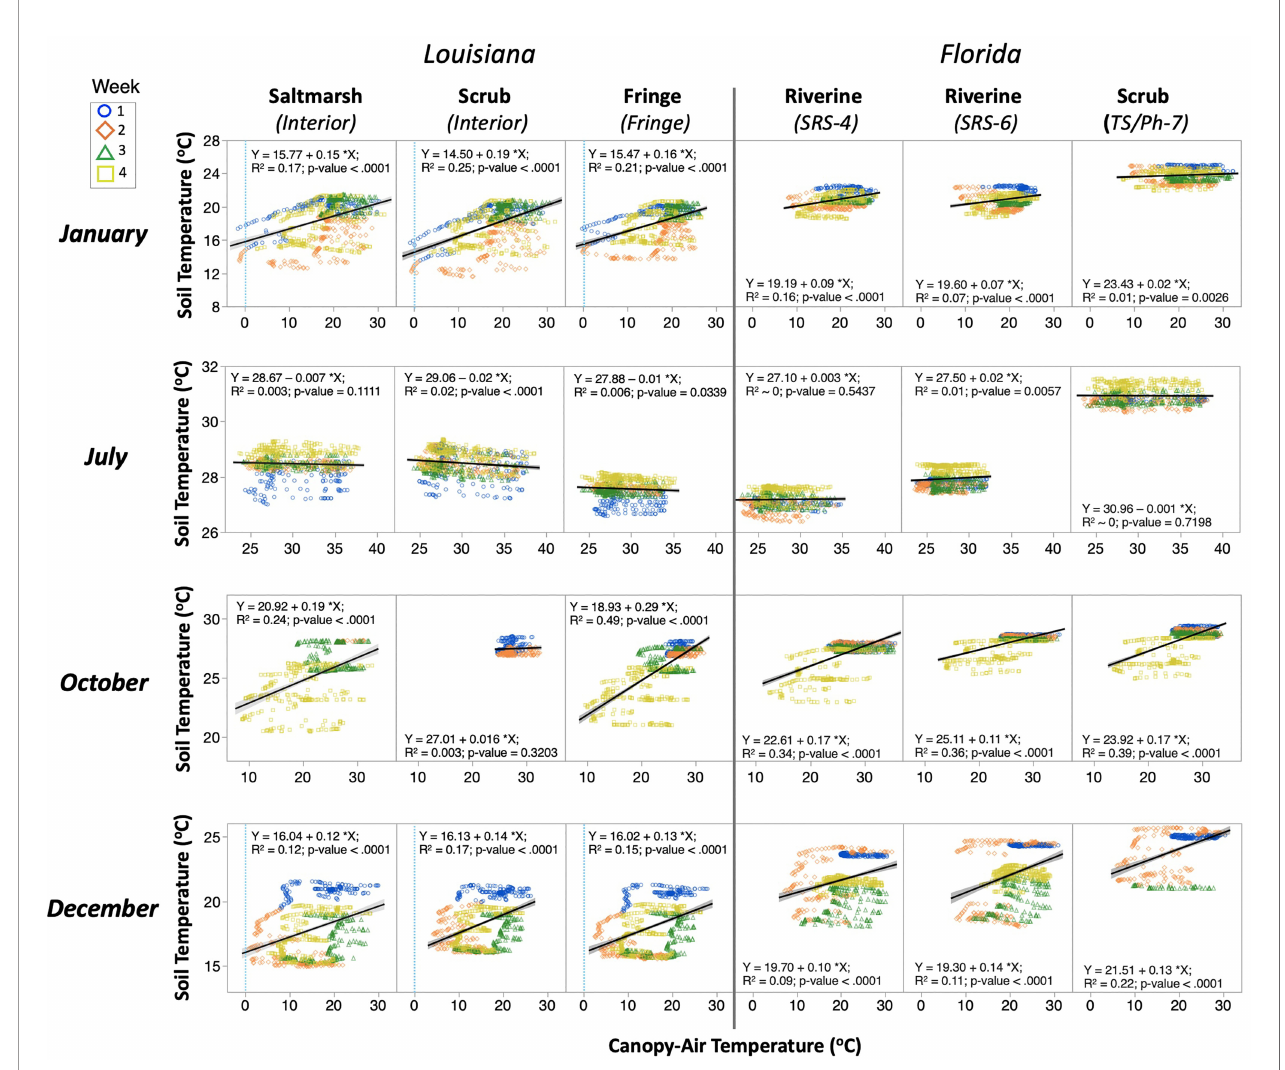
FIGURE 4 | Linear regressions between hourly canopy-air and soil temperature recorded in selected wetland sites and months in 2017. The gray shade indicates the 95% con fi dence interval. The colored icons represent the week in a month when temperature was recorded. Notice the x- and y-axis scales are different among months. Light blue dashed lines mark the zero value in the winter months (January and December) in the Louisiana study